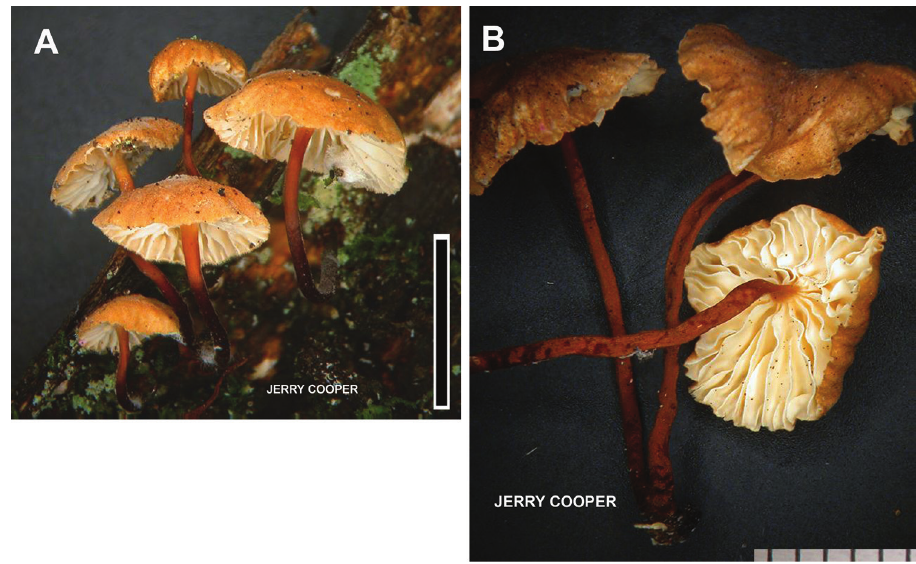
Figure 28. Mycetinis curraniae . Basidiomata. A PDD 86987 B PDD 95705. Standard bars: A = 10 mm. B Ruler in millimeters. Photo courtesy J.